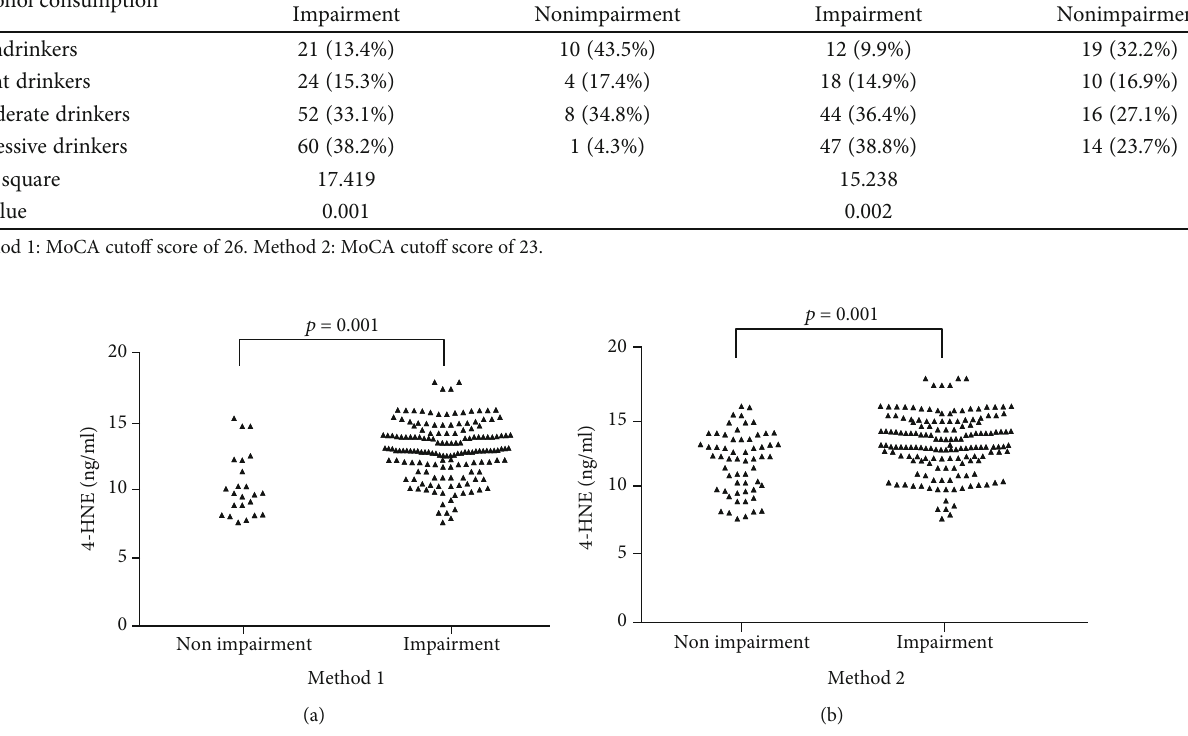
Figure 3: Comparison of 4-hydroxy-trans-2-nonenal (4-HNE) levels between the cognitive impairment and nonimpairment groups according to two di ff erent Montreal Cognitive Assessment (MoCA) cuto ff scores: (a) score of 26; (b) score of